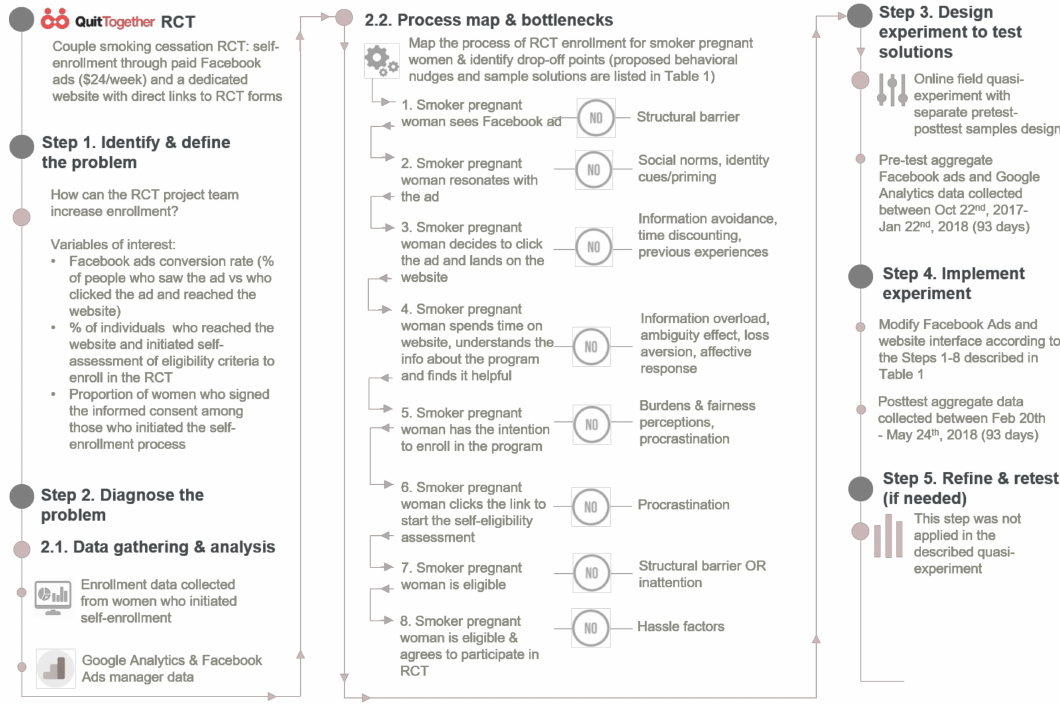
Figure 1. The application of the Behavioral diagnosis and design framework [13] to the quasi-experiment designed to increase enrollment in the Quit Together (QT) randomized controlled trial